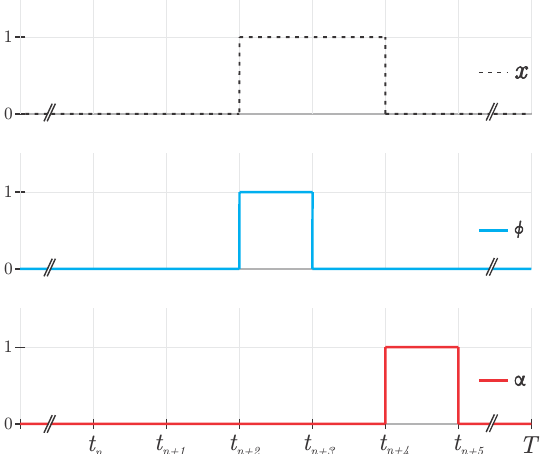
Figure 1. Behavior of auxiliary variables φ and α in relation to a given job x